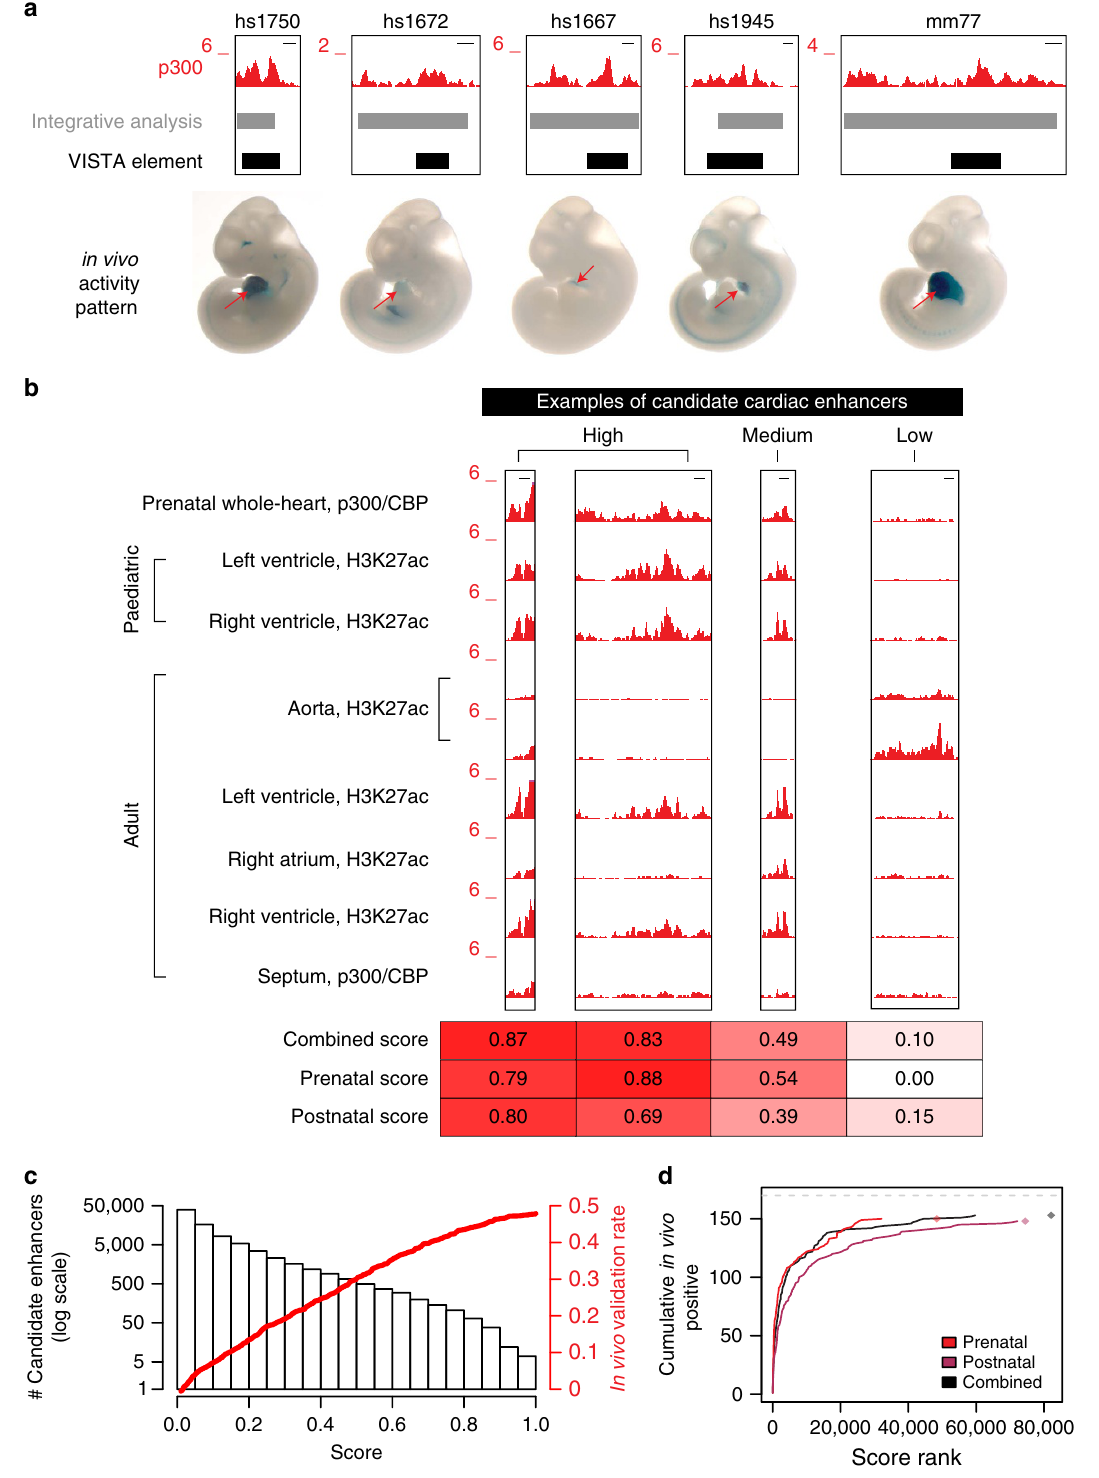
Figure 2 | Integrative analysis of heart ChIP-seq data identifies 4 80,000 heart enhancers. ( a ) Examples of heart enhancers identified through this analysis that had previously been validated in transgenic mouse assays 24 . For each locus, we show the raw p300/CBP ChIP-seq signal from foetal human heart, the locations of the integrative analysis-identified enhancer and the tested element, and a representative E11.5 embryo. The heart is indicated by a red arrow. hs/mm numbers indicate the VISTA identifier. Scale bars, 1kb. ( b ) Representative examples of putative enhancers with high, medium and low levels of support. Raw ChIP-seq data from all human heart samples analysed is shown, along with the corresponding confidence scores for each locus. ( c ) Histogram of combined scores for all 82,119 putative heart enhancers identified by the integrative analysis (left axis). Superimposed (red) is the retrospective heart enhancer validation rate versus combined score for all in vivo tested sites that overlap scored regions (see the ‘Methods’ section). ( d ) Cumulative proportion of in vivo -validated heart enhancers captured by score rank. Dashed gray line indicates the total number of validated heart enhancers considered (170). Rhombi indicate the total number of scored loci in each